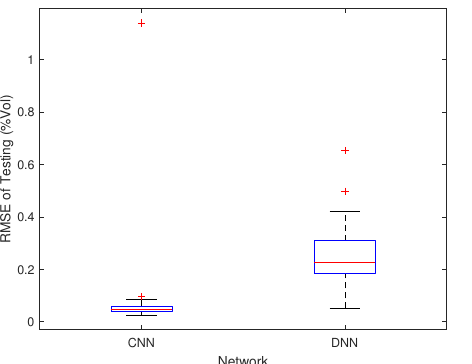
Figure 11. Comparison between soil moisture retrieval performances of the trained